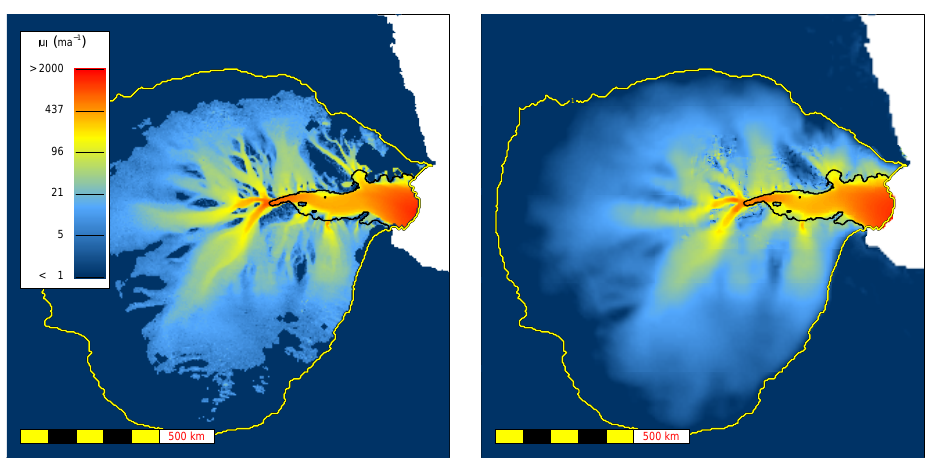
Figure 2. Rignot et al. (2011) observed (left) ice flow speed over the AIS drainage basin (top) and BISICLES ice flow speed over the whole computational domain (right). The present-day drainage basin boundary and grounding line are indicated by solid contours.